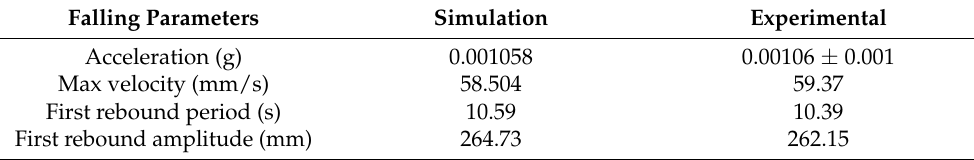
Table 4. Comparison of simulation and test results with external force of 0.98 N. Falling